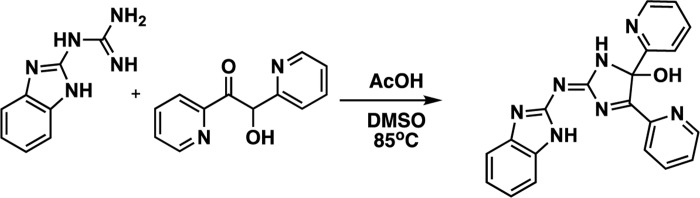
Synthesis of IODVA1.